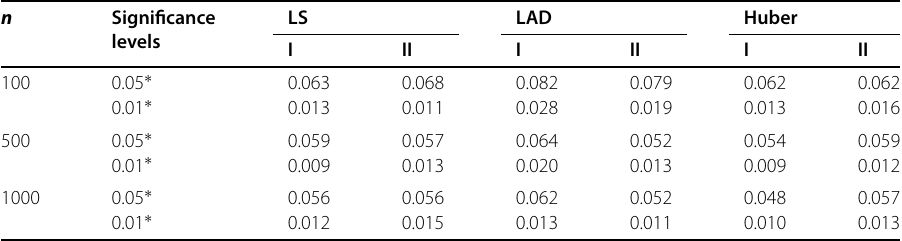
Table 2 The powers of the M-test with NSD errors, ‘ ∗ ’ is for the nominal significant levels n Significance